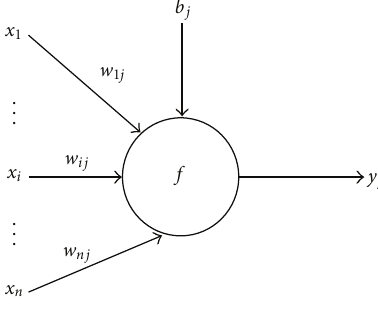
Figure 2: Schematic diagram of node j